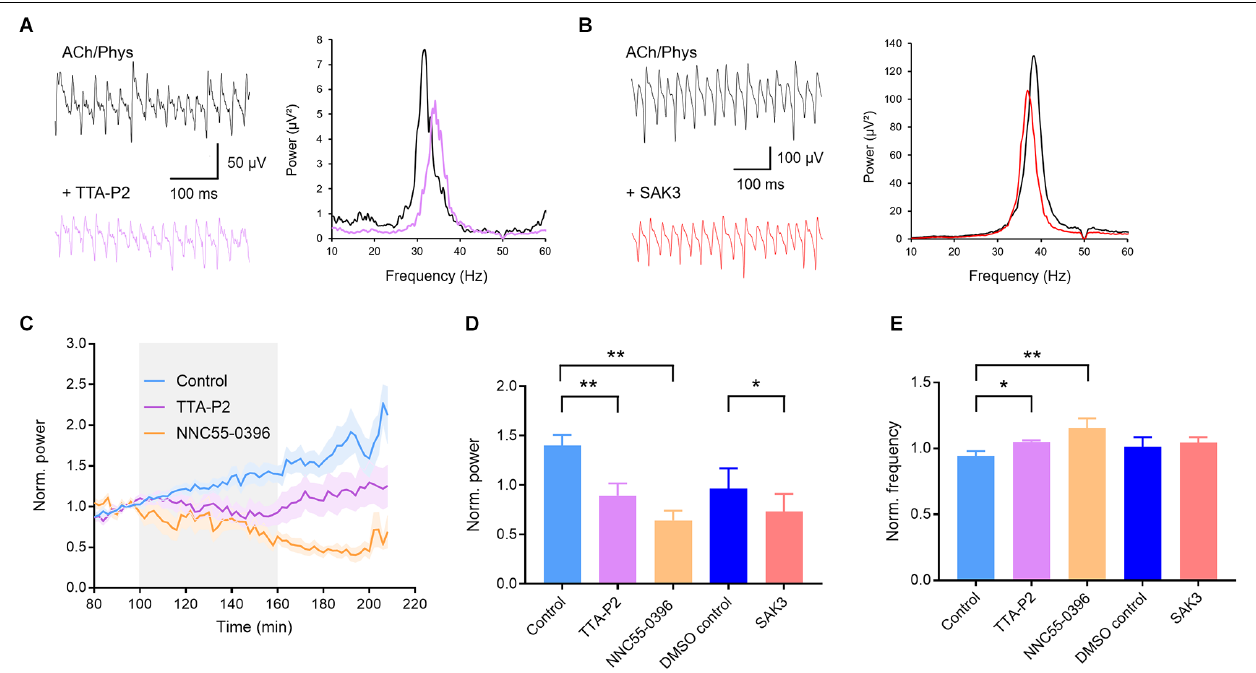
FIGURE 4 | Selective ligands of T-type calcium channels inhibit cholinergic gamma oscillations in rat hippocampal slices. (A) Original traces (left) and power spectra (right) of cholinergic gamma oscillations before (black) and after (purple) application of the selective T-type calcium channel blocker TTA-P2 (1 µ M). (B) Original traces (left) and power spectra (right) of cholinergic gamma oscillations before (black) and after (red) application of the selective T-type calcium channel enhancer SAK3 (0.1 µ M). (C) Normalized power before, during and after bath application (gray) of the selective T-type blocker TTA-P2 (1 µ M, purple) and NNC55-0396 (100 µ M, orange) compared to control (blue). (D) Effect of the T-type calcium channel blockers TTA-P2 and NNC55-0396 as well as the enhancer SAK3 on the power of hippocampal gamma oscillations compared to time matched and solvent control. Control (light blue): n = 13 slices, N = 9 animals; TTA-P2 (1 µ M, purple): n = 14, N = 6, p = 0.005, NNC55-0396 (100 µ M, orange): n = 6, N = 2, p = 0.001; DMSO control (dark blue): n = 8, N = 7; SAK3 (0.1 µ M, red): n = 10, N = 6, p = 0.020. (E) Effect of the T-type calcium channel blockers TTA-P2 and NNC55-0396 as well as the enhancer SAK3 on the peak frequency of hippocampal gamma oscillations compared to time matched and solvent control. TTA-P2 (1 µ M, purple): p = 0.042; NNC55-0396 (100 µ M, orange): p = 0.001; SAK3 (0.1 µ M, red): p = 0.306. Recording temperature was between 34 and 36 ◦ C. Traces were lowpass filtered at 200 Hz and bandstop filtered at 50 Hz. Bars show mean ± SEM. * p < 0.05, ** p < 0.01. ACh, acetylcholine; Phys,